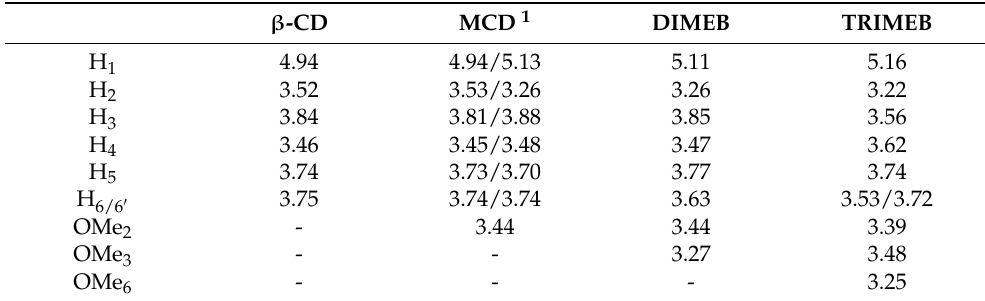
Table 1. 1 H NMR (600 MHz, 12 mM, K 2 HPO 4 /D 2 O 50 mM, 25 °C) chemical shifts (ppm) of β -CD, MCD, DIMEB, and TRIMEB protons.